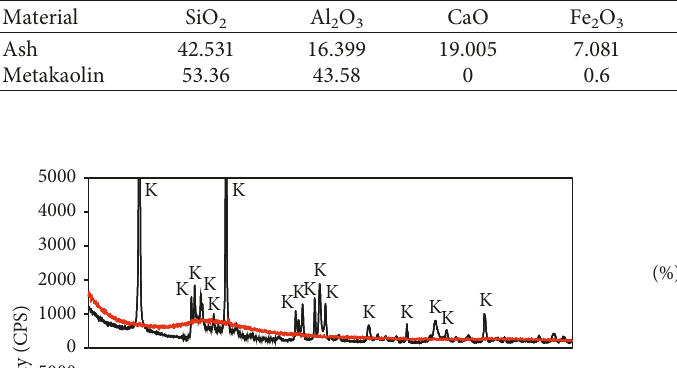
Table 3: Chemical composition in % of ash and of metakaolin.